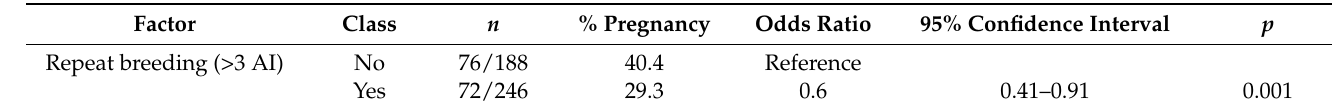
Table 3. Odds ratios for the small follicle presence variables included in the final logistic regression model ( n =